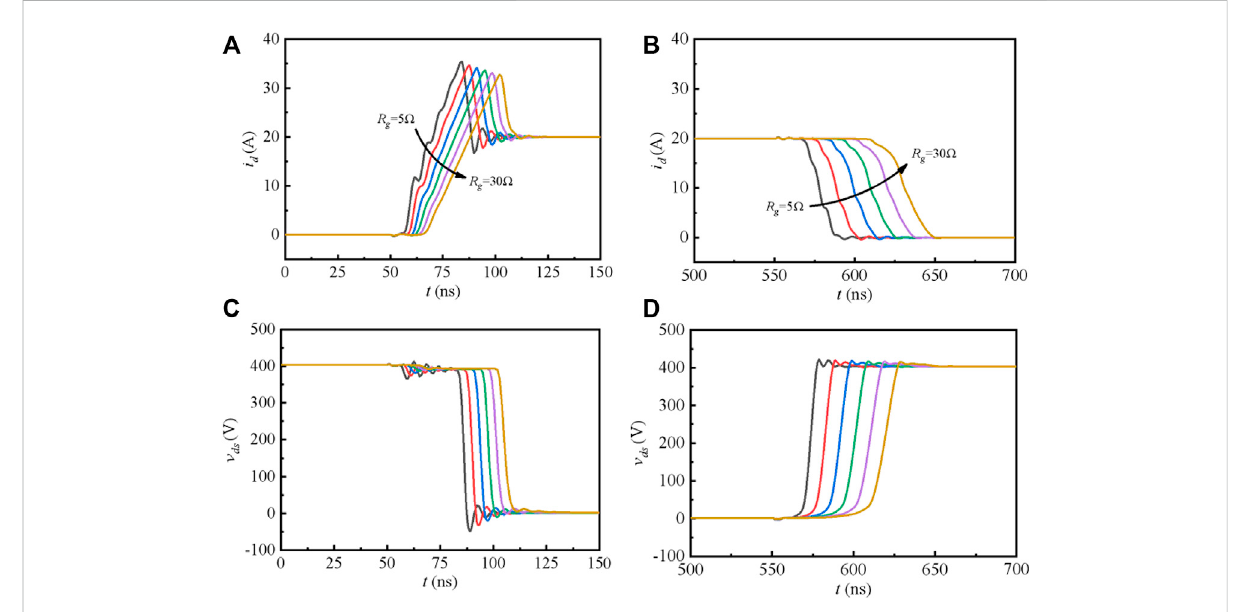
FIGURE 4 In fl uence of R g on the switching behavior of the SiC MOSFET. (A) Turn-on i d . (B) Turn-off i d . (C) Turn-on u ds . (D) Turn-off u ds .